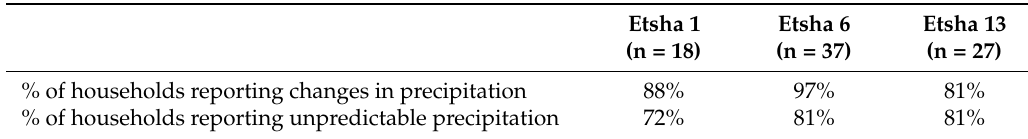
Table 1. Perceptions of changes in